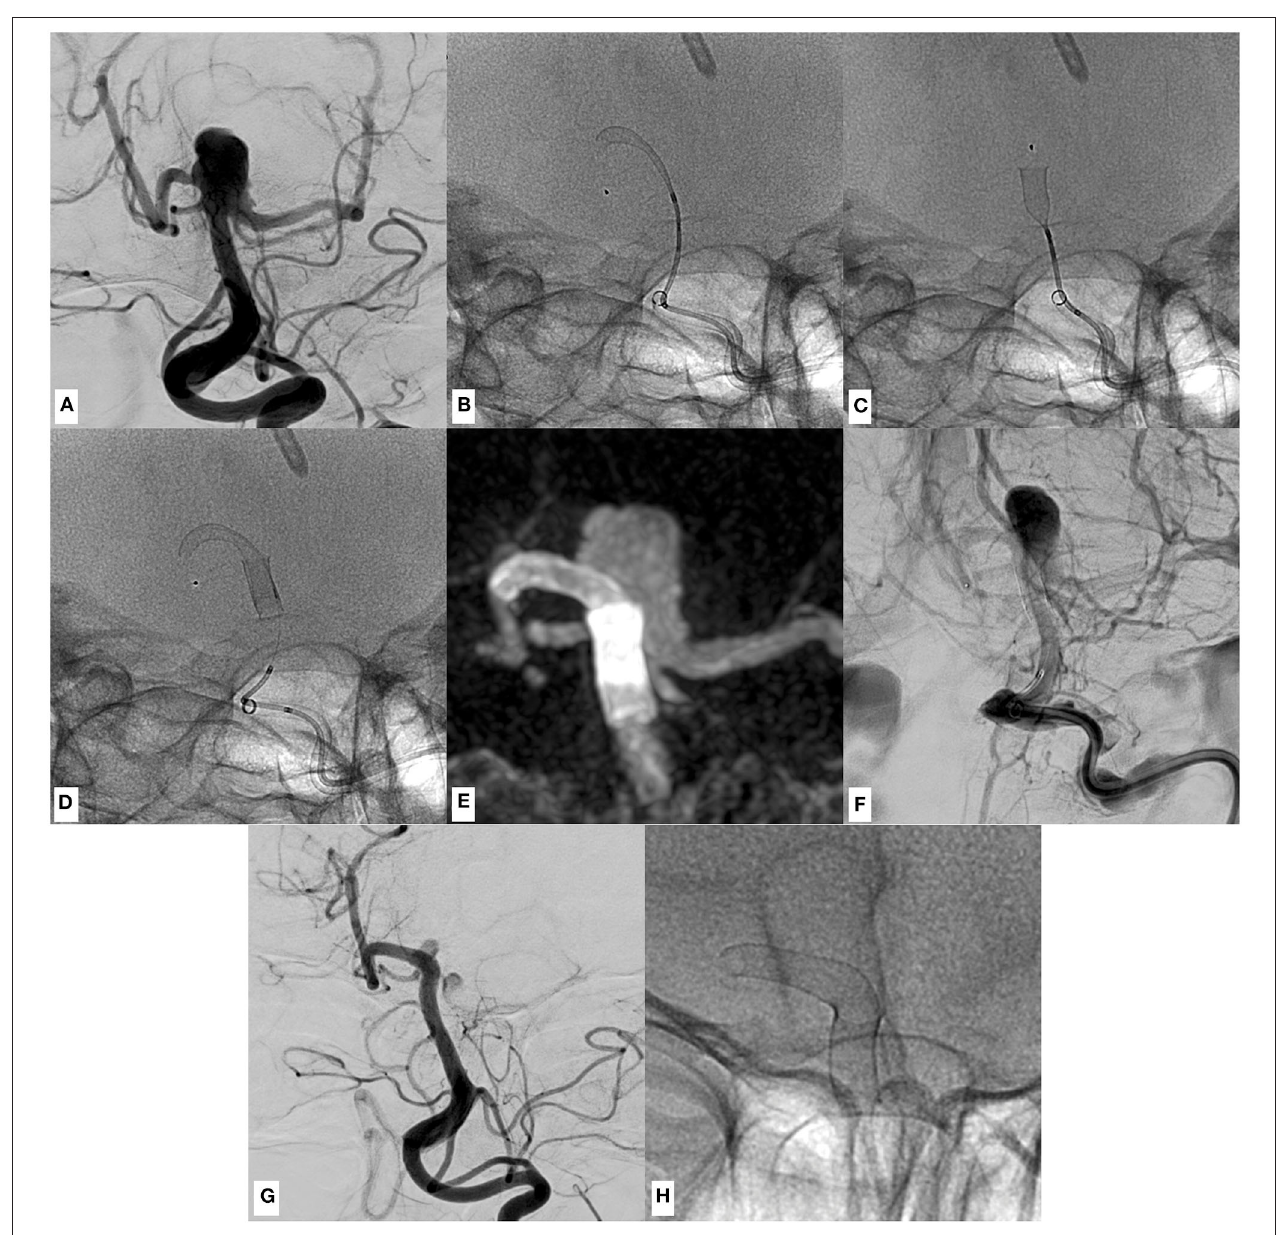
FIGURE 3 | An example of p48MW hydrophilic coating (HPC) implantation in the right posterior cerebral–basilar artery (BA) junction for treatment of a broad-based, partially thrombosed, un-ruptured aneurysm arising from the basilar tip, causing progressive hydrocephalus. (A) Conventional angiogram in working projection shows the perfused part of the saccular, broad-based aneurysm of the BA–posterior cerebral artery (PCA) complex (neck, 7 mm; fundus, 7 × 8 mm). (B) Positioning of the first p48MW HPC. The distal landing zone, aiming to cover the smallest perforator-rich area as possible, was defined as comparatively short. Note the distal end of the movable wire (radiopaque olive) within the distal P1 segment, which was used to further stabilize the system during implantation. In retrospect, a more distal positioning of the MW in the middle part of the P2 segment may have prevented dislocation of the first device, as demonstrated in the following images. (C) Simultaneous to the deployment of the device, significant distal shortening and subsequential proximal dislocation of the entire device occurred, requiring the implantation of a second p48MW HPC in order to sufficiently cover the broad aneurysmal orifice. (D) Device radiogram showing the second p48 implanted in telescoping technique. Now the aneurysm is covered sufficiently. Initially, wall apposition/flow diverter opening appeared to be only moderate, which resolved a few minutes after implantation without the necessity for further manipulation. (E) Maximum intensity projection of the flat-panel CT shows the flow diverter stent (FDS) construct and its relation to the BA–PCA junction and the broad-based aneurysm. (F) Venous phase of a digital subtraction angiography (DSA) run in working projection after successful implantation shows protracted opacification of the aneurysm sac (O’Kelly Marotta: A3) indicating the extent of the flow diversion effect. (G) Follow-up DSA in working projection 3 months later shows the remodeled posterior circulation with a minimally perfused remnant of the aneurysm. (H) Device radiography in corresponding projection.